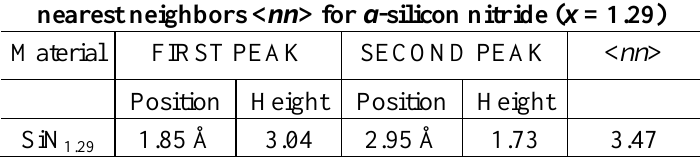
Table 3. Topological parameters for the RDF of the stoichiometric SiN amorphous